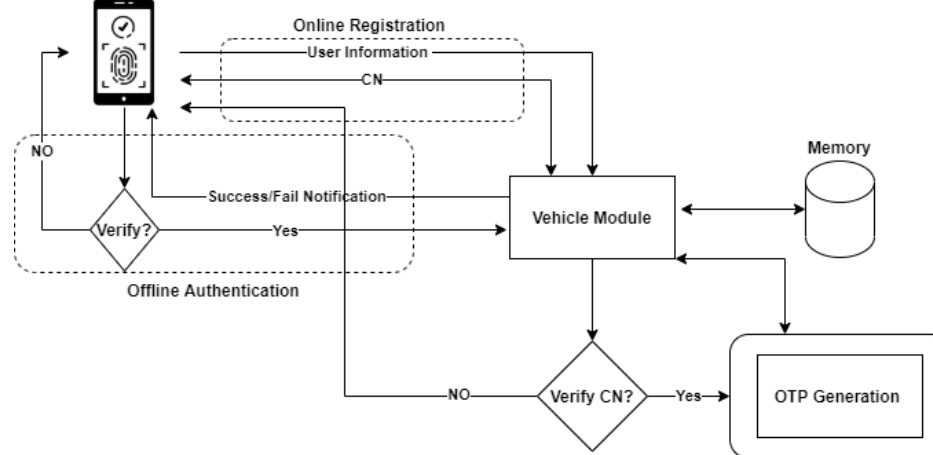
Figure 8. The offline authentication network diagram.